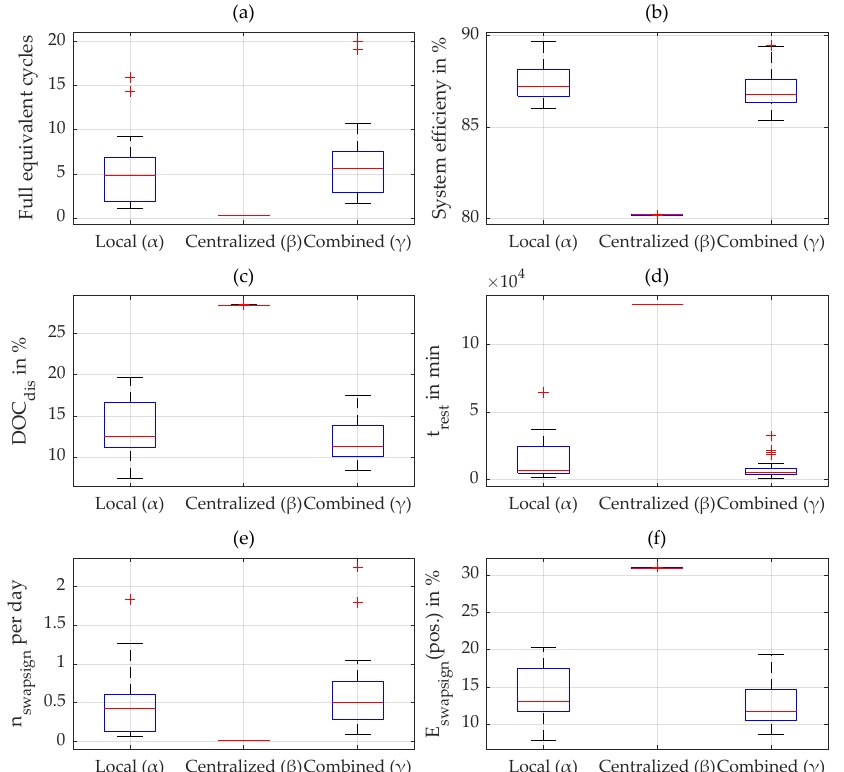
Figure 8. Detailed results about the additional stress on the battery energy storage systems (BESSs) for a six month simulation period. Subplot ( a ) shows the number of full equivalent cycles and the mean round-trip efficiency in % is displayed in subplot ( b ). Subplot ( c ) shows the average cycle depth in discharge direction in % and the average resting time in minutes between two actions is illustrated in subplot ( d ). The number of alternations between charging and discharging (sign changes) per day is indicated in subplot ( e ). Finally, subplot ( f ) shows the energy in relation to the BESS capacity that is charged between these sign